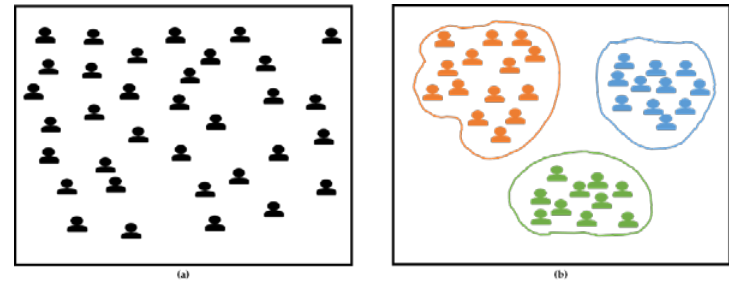
Figure 4. Cluster structure: ( a ) before cluster; ( b ) after cluster.